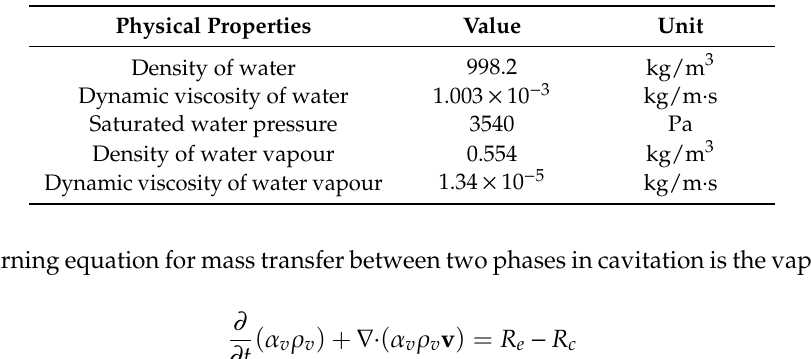
Table 2. Physical properties of water and water vapour at room